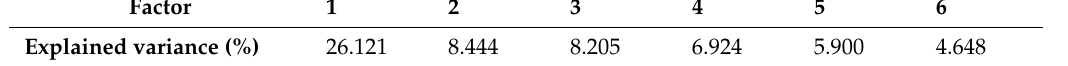
Table 2. Factorial structure of the Inflammatory Bowel Disease Disability Index after Varimax rotation.